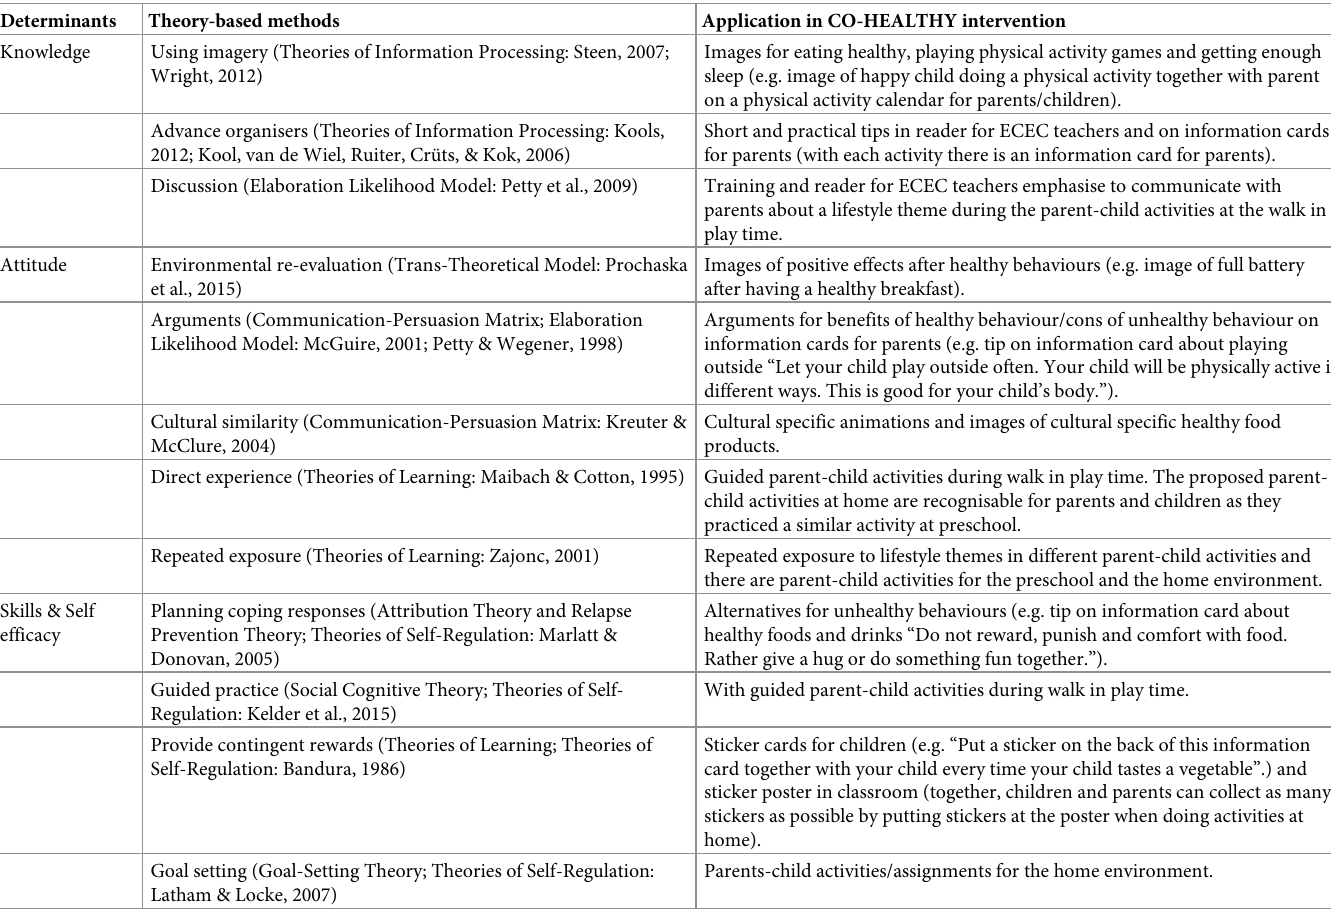
Table 2. Overview of the CO-HEALTHY applicants and their underlying theory-based methods to change the behavioural determinants of the preschoolers’ parents.